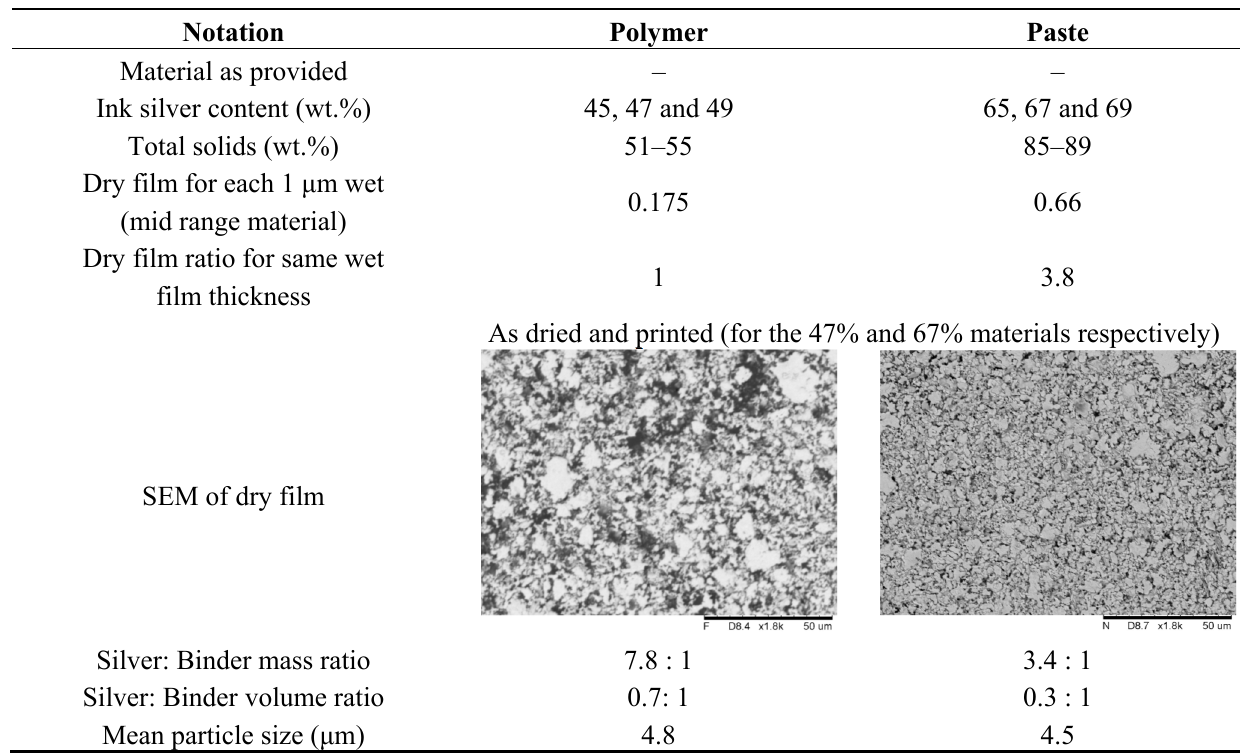
Table 1. Silver material